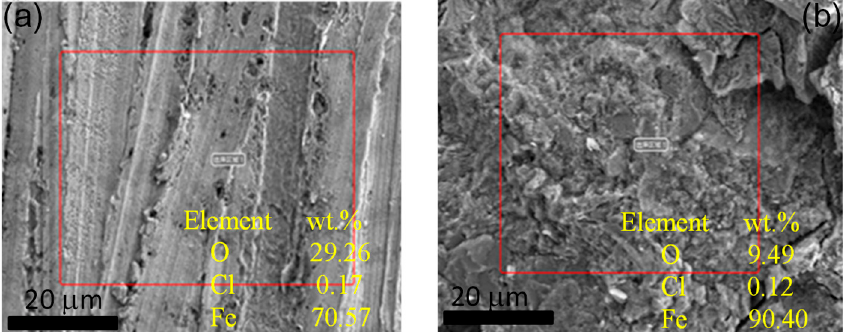
Figure 11. SEM images of steel surfaces with the protective coatings peeled off after exposure to 3.5 wt.% NaCl solution for 30 days: ( a ) three-layer core-shell emulsion coating (the scratches were due to previous grinding with sandpaper) and ( b ) conventional core–shell emulsion coating (the elemental compositions of rust were obtained by EDS within the red square).